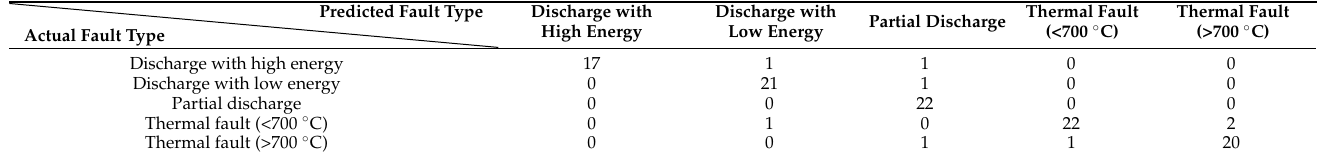
Table 3. Confusion matrix of the bagging output.